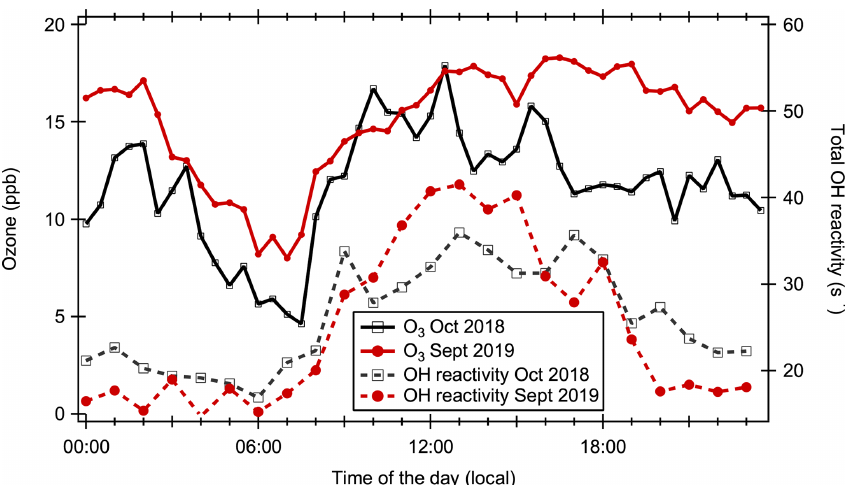
Figure 3. Diel cycles of ozone mixing ratios (left axis) and total OH reactivity (right axis) at ∼ 80m height a.g.l. for the two dry seasons, October 2018 and September 2019. Values shown are the hourly (reactivity) or half-hourly (ozone) diel averages over the measurement